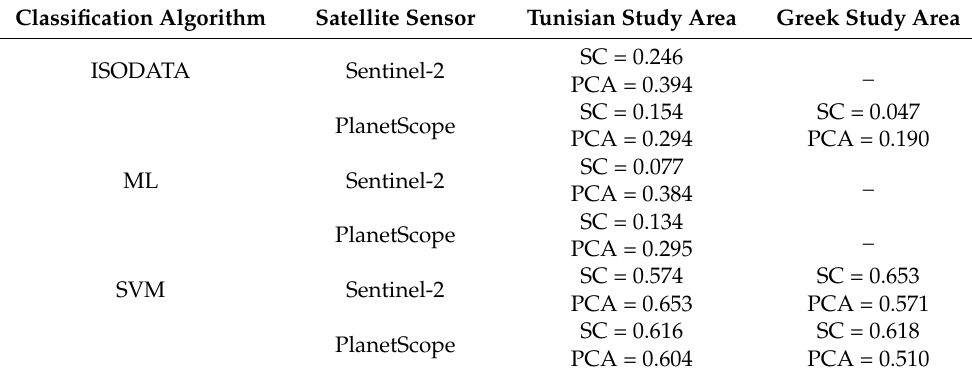
Table 6. Results of kappa index calculated for images acquired during February for different classifi- cation